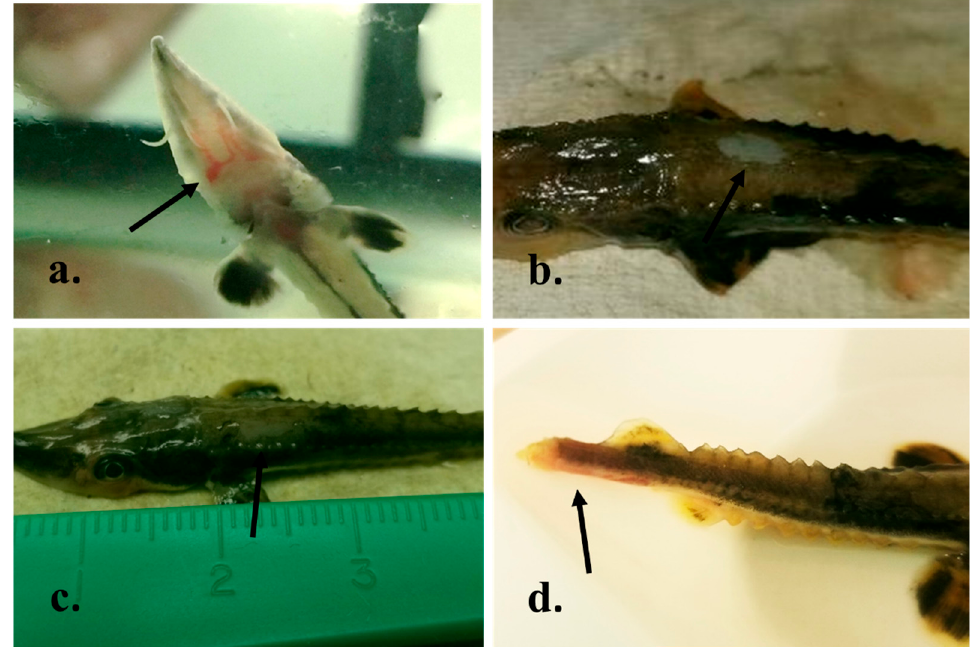
Figure 6. Gross disease signs observed in juvenile lake sturgeon ( Acipenser fulvescens ) exposed to the newly isolated lake sturgeon herpesvirus via intracolemic injection ( a , c ) or immersion bath ( b , d ); isolate 200413-11TC). ( a ) Hemorrhage surrounding the oral siphon extending linearly to the barbels indicated with the arrow. ( b , c ) Focal ulceration of the skin extending into the underlying musculature indicated with arrows. ( d ) Severe caudal fin erosion extending into the caudal peduncle (arrow), contiguous with marked pallor extending anteriorly to the